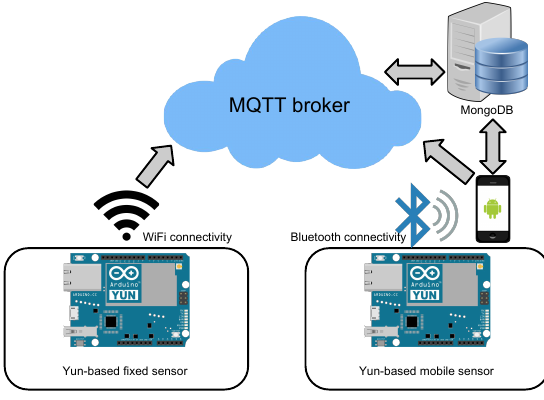
Figure 3. Communication